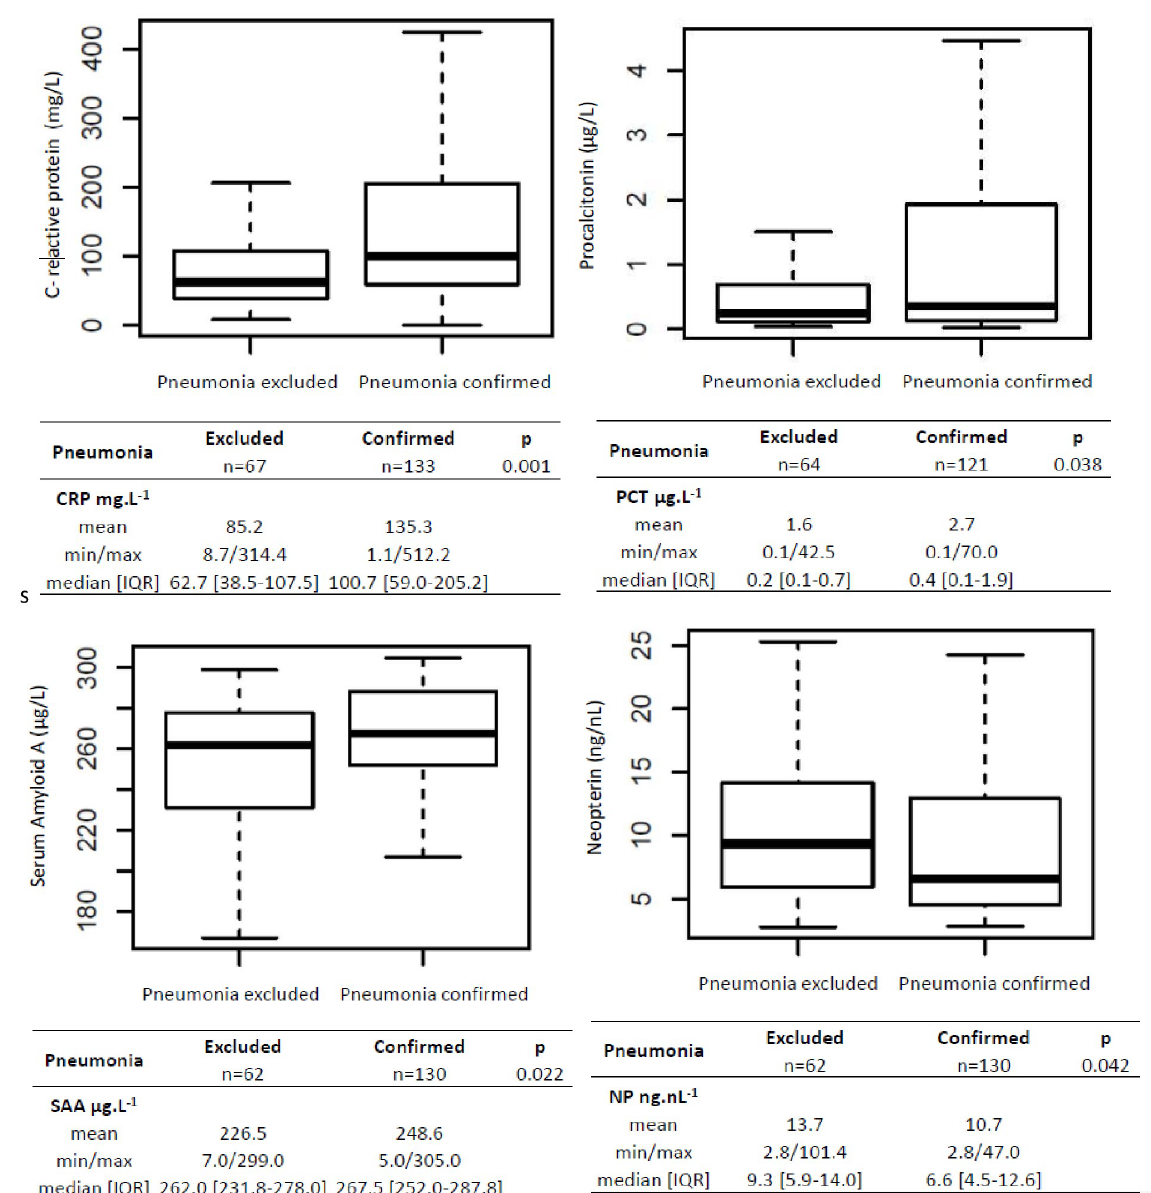
Fig 1. C-reactive protein (CRP), procalcitonin (PCT), Serum Amyloid A (SAA) and neopterin (NP) boxplot in patients with and without